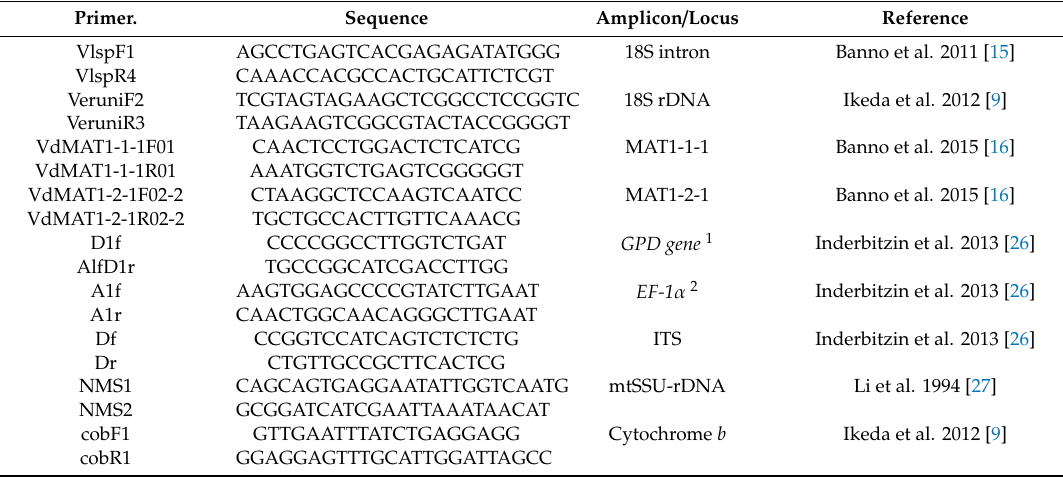
Table 2. Primers used in PCR assays to confirm the identity of Verticillium species in this study.